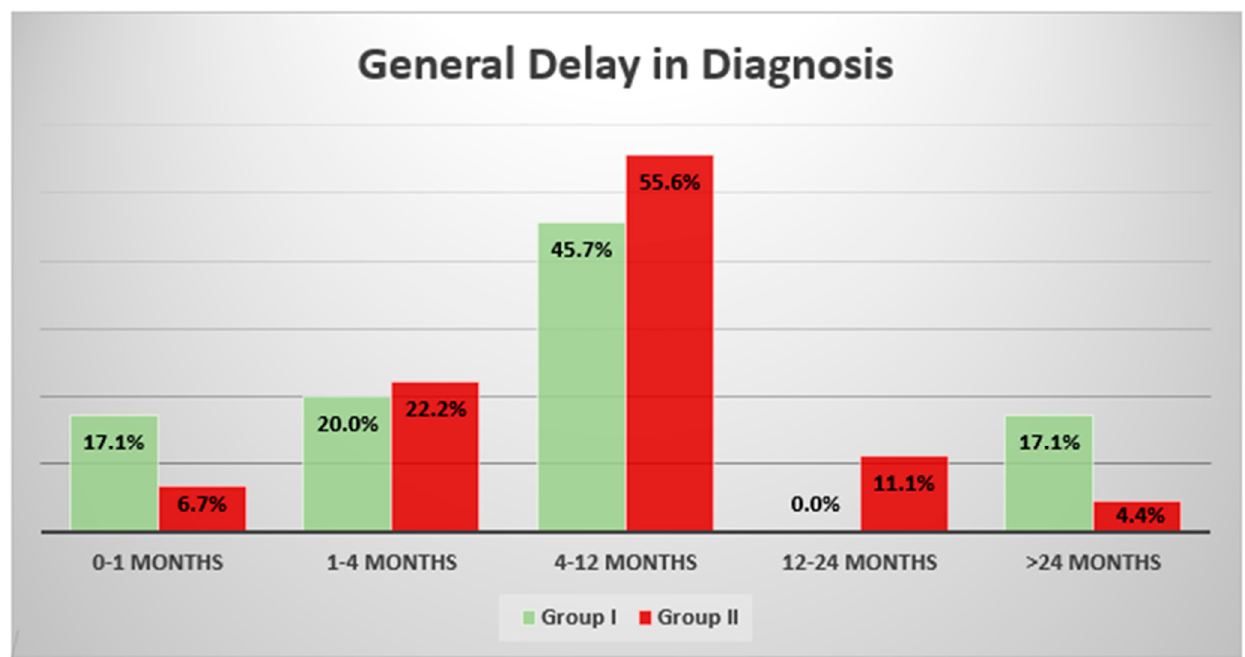
Figure 1. Graph presents the general delay in diagnosis of bone neoplasms. There were no signifi- cant differences between the groups ( p > 0.05). Moreover, within the recommended delay time, which should not exceed 4 months, in Group I, this result was achieved by 37.1% of patients, and in Group II, it was achieved by 28.9% of patients ( p = 0.821).